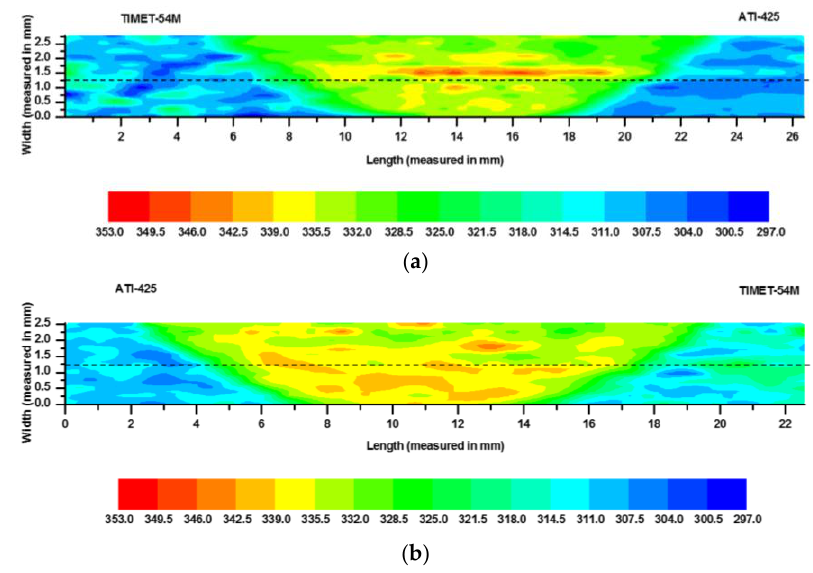
Figure 8. Color-coded microhardness profiles on the transverse cross-sections of the weld. ( a ) P1; and ( b ) P4.